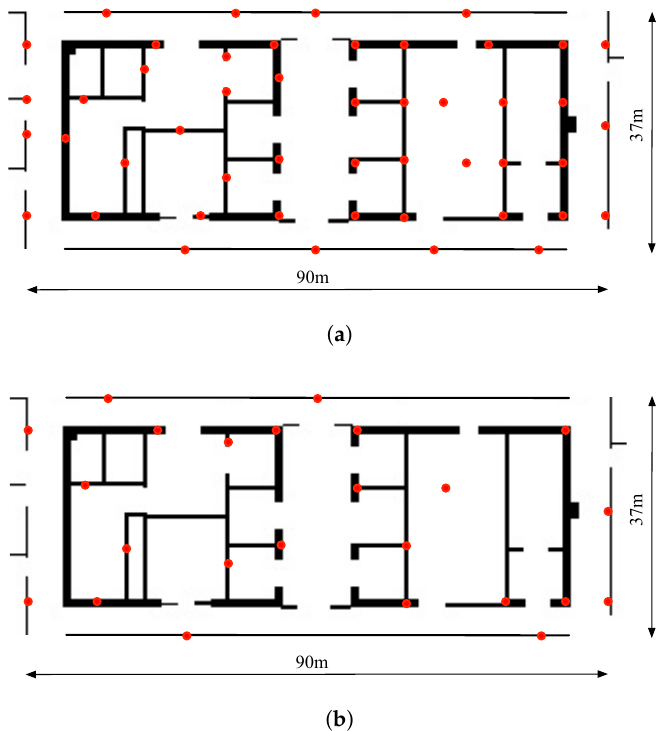
Figure 7. The positions of BLE beacons installed in the site (on the walls or on the furniture surfaces) ( a ) Densely deployed BLE beacons ( b ) Sparsely deployed beacons. In our implementation, we just ignore some of the RSSI readings to simulate the situation of sparsely deployed